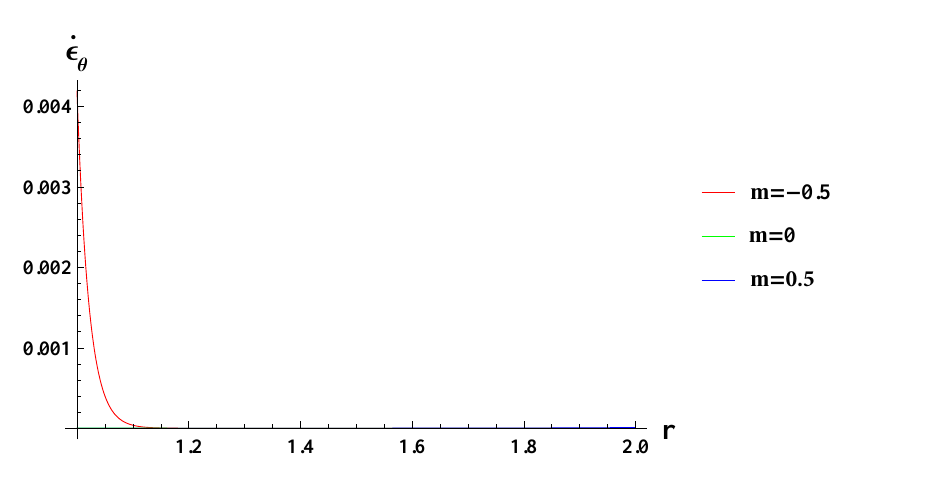
Figure 15. Tangential strain rate along the radius r (in cm) of the cylinder, under the effect of rotation ( ω 2 = 50 rad/s), internal pressure p i = 50 MPa and linear volume reinforcement.